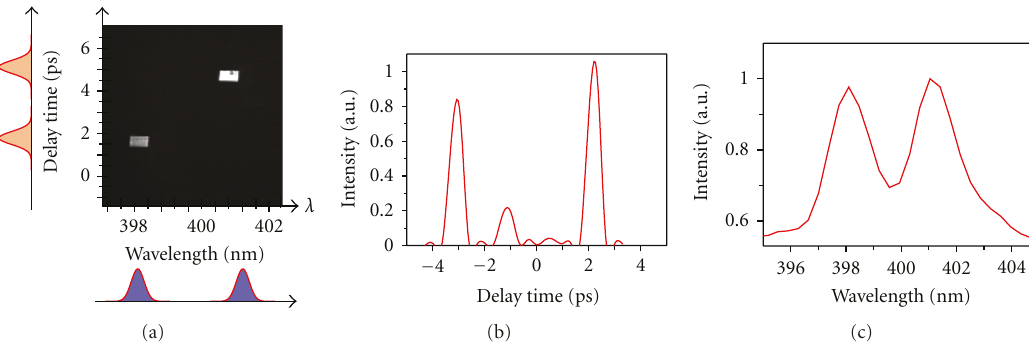
Figure 4: Experimental results for dropped signal ( λ 1 , t 1 ) and (b) ( λ 5 , t 4 ): (a) spatial distribution, (b) temporal waveform, and (c) spectrum.